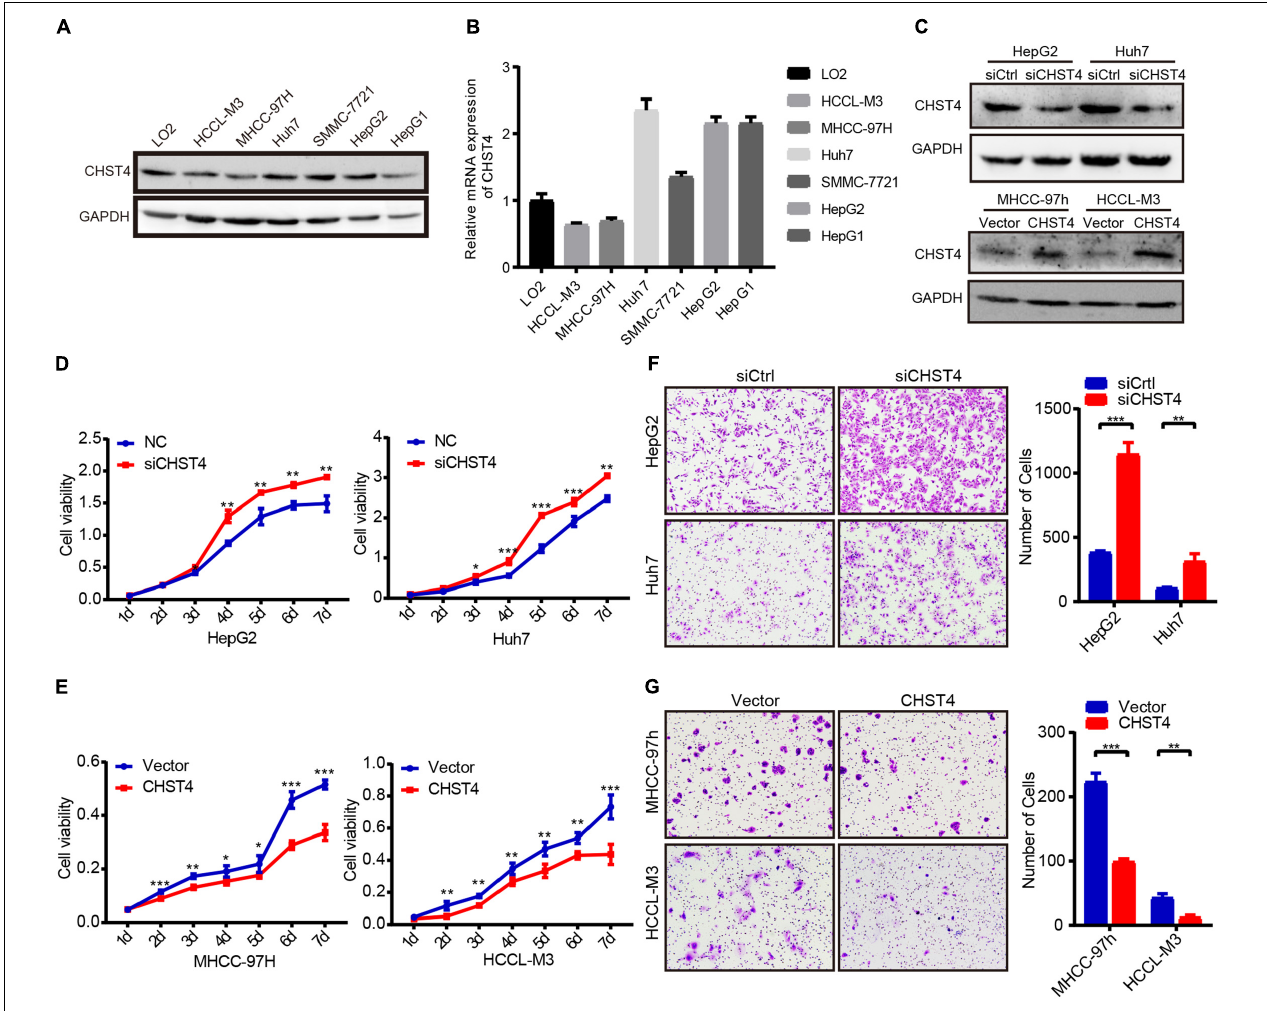
FIGURE 5 | CHST4 inhibits the proliferation and migration of HCC cells. (A,B) Protein and mRNA expression of CHST4 in various HCC cell lines. (C) Knockdown efficiencies were validated in HepG2 and Huh7 cells, and overexpression efficiencies were validated in MHCC-97h and MCCL-M3 cells by Western blot. (D,E) Effects of CHST4 knockdown and overexpression on HCC proliferation determined by CCK-8 assays. Bars represent the mean ± SD; * P < 0.05, ** P < 0.01, *** P < 0.001 (Student’s t -test). (F,G) Effects of CHST4 knockdown and overexpression on HCC migration were determined by Transwell assays. The right panels show the respective quantitative histograms. All experiments were performed in triplicate. Bars represent the mean ± SD; * P < 0.05, ** P < 0.01, *** P < 0.001 (Student’s t